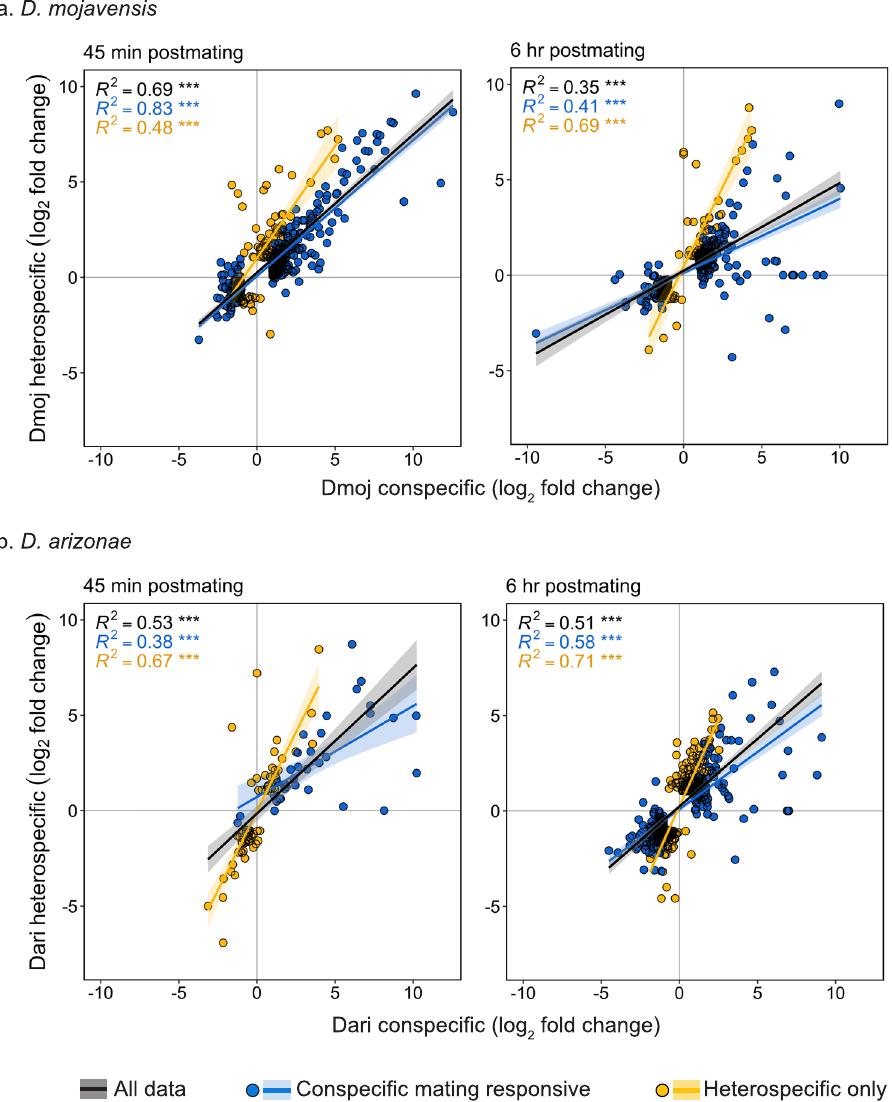
Fig. 7 Transcriptional correlations for DE genes between con- vs heterospeci fi c matings in D. mojavensis and D. arizonae . Scatterplots represent the relationship of relative fold changes (log 2 ) between con- vs heterospeci fi c matings at 45 min and 6 h postmating in a D. mojavensis and b D. arizonae . Log 2 fold changes are relative to virgin females. Genes colored in blue are all conspeci fi c mating responsive genes. Genes colored in yellow are those that were DE in the heterospeci fi c cross but not the conspeci fi c cross ( “ heterospeci fi c only ” ). Pairwise Pearson ’ s R 2 correlation coef fi cients and linear method trend- lines (with 95% con fi dence intervals shaded) are shown. The black regression line is fi tted through all the data (blue and yellow combined). P -values of correlations are noted: *** P <